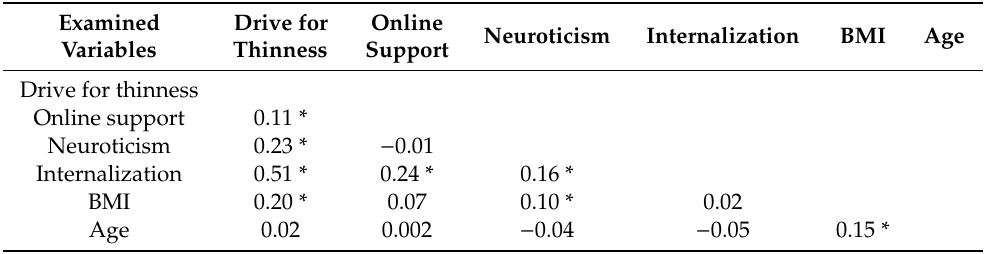
Table 1. Correlations among